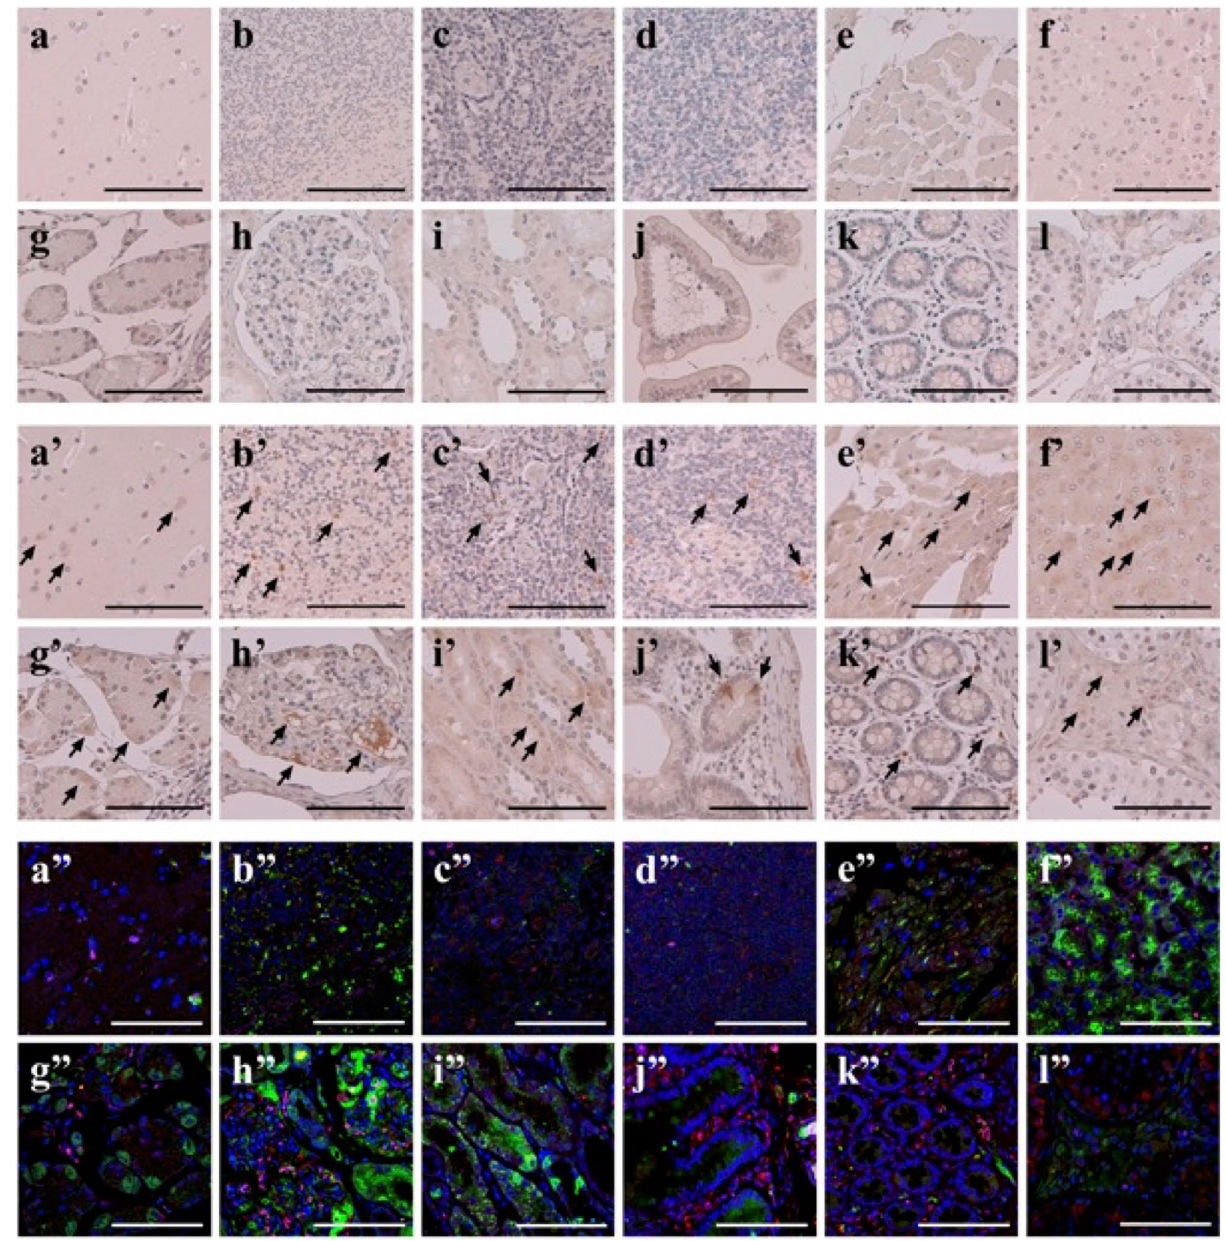
Figure 6. Systemic expression of GIP_HUMAN[22–51] and its negative colocalisation with GIP in major human organs. ( a–l , a ’– l ’) Human tissue array sections were immunohistochemically stained with either IgG purified from preimmune rabbit serum ( a–l ) or anti-GIP_HUMAN[22–51] IgG at 1:500 dilution ( a ’– l ’). Arrows indicate the positions of positive immunoreactivity. ( a” – l” ) Confocal microscopic images of immunofluorescent dual staining of GIP_HUMAN[22–51] and GIP. Human tissue array sections were double-stained with either the rabbit polyclonal anti-GIP_HUMAN[22–51] antibody (× 1000) or the mouse monoclonal anti-human GIP antibody (× 500). The red signals corresponding to the localisation of GIP were obtained with the Alexa Fluor 594 secondary antibody (× 1000) and the green signals representing GIP_HUMAN[22–51] were obtained with the Alexa Fluor 488 secondary antibody (× 500). The nuclei were counterstained with DAPI (blue). Overlay resulted in yellow signals indicative of colocalisation. ( a–a” ) cerebral cortex, ( b – b ”) cerebellum, ( c – c ”) tonsil, ( d – d ”) lymph node, ( e – e ”) heart, ( f – f ”) liver, ( g – g ”) stomach, ( h – h ”) kidney (glomerulus), ( i – i ”) kidney (tubule), ( j – j ”) small intestine, ( k – k ”) colon and ( l – l ”) testis (scale bar: 100